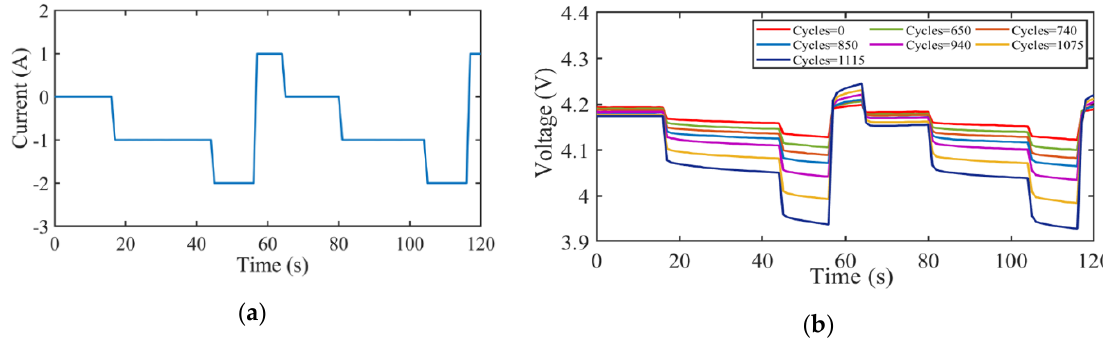
Figure 1. Voltage variation: ( a ) current; ( b ) voltage.